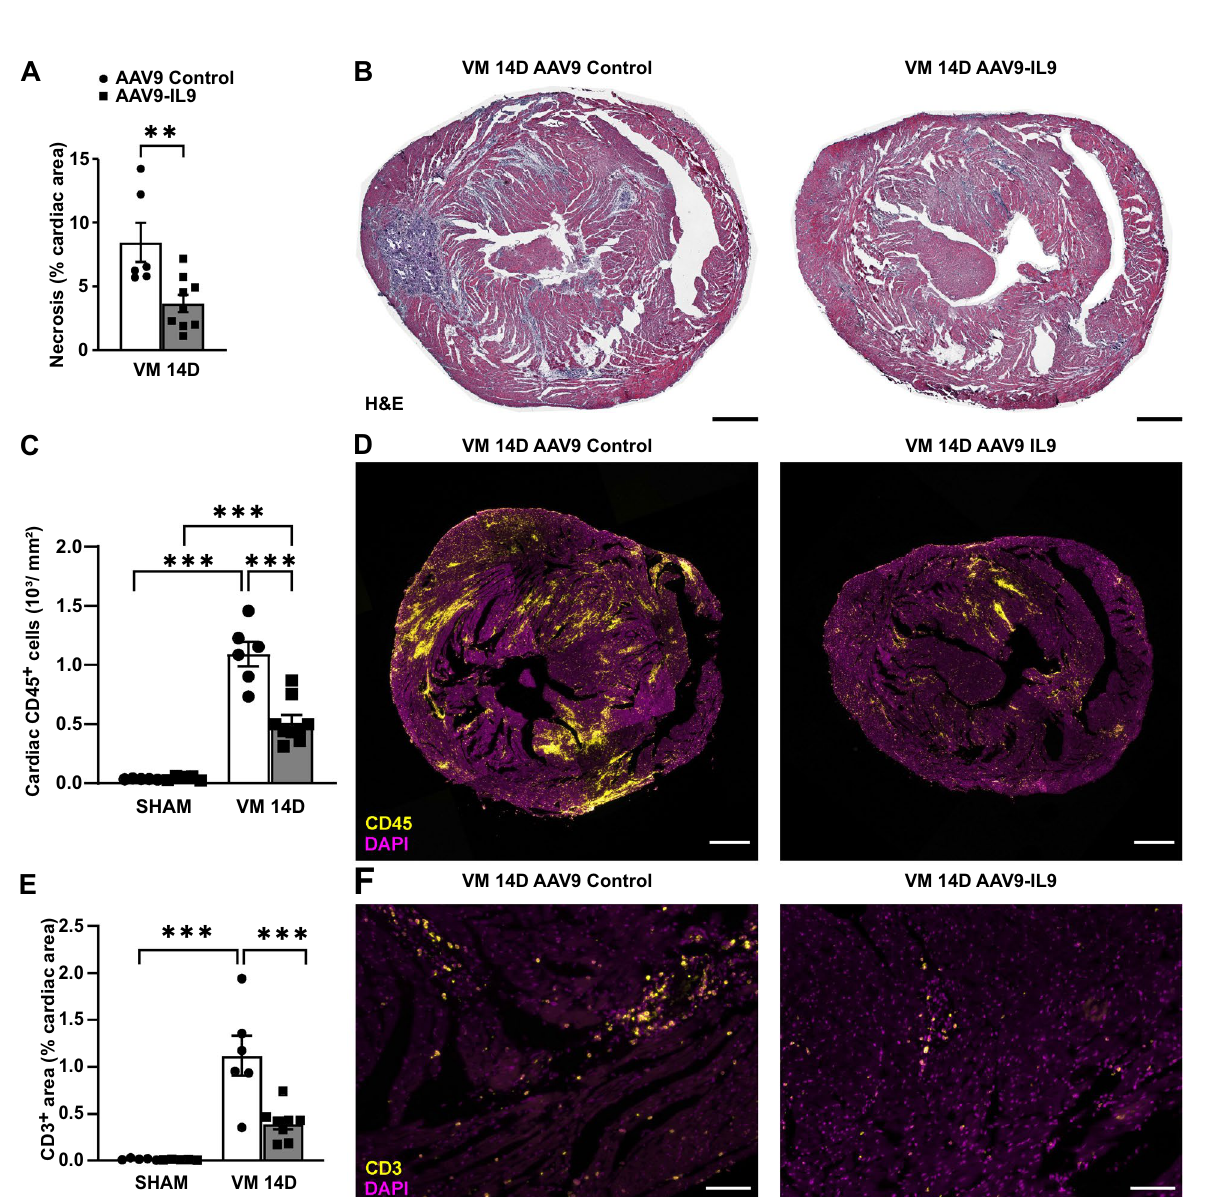
Figure 6. IL9 overexpression improves VM outcome, decreasing T lymphocyte response in the acute phase. ( A , B ) Cardiac necrosis detected by hematoxylin and eosin (H&E) staining 14 days after CVB3 infection in IL9-overexpressing hearts and controls. Scale bar = 500 µm. Significance assessed by Mann–Whitney U test with **p ≤ 0.01. ( C , D ) CD45 staining (leukocytes) in infected IL9-overexpressing and infected control hearts at 14 days post-infection. Scale bar = 500 µm. Significance assessed by two-way ANOVA followed by Tukey’s test with ***p ≤ 0.001. ( E , F ) CD3 staining (T lymphocytes) in infected IL9-overexpressing and infected control hearts 14 days after CVB3 infection. Scale bar = 100 µm. Significance assessed by two-way ANOVA followed by Tukey’s test with ***p ≤ 0.001. All values are expressed as mean ±